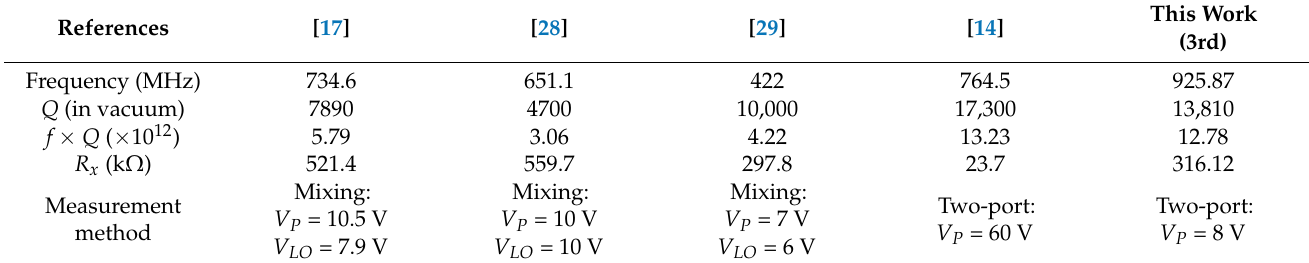
Figure 10. The top and side views of the 3rd WEM mode shape ( a ) and the normalized displacement of the 3rd WEM vs. the coordinates along the width ( b ). Table 4. The f × Q product comparison between the reported UHF silicon-based resonators and this work.